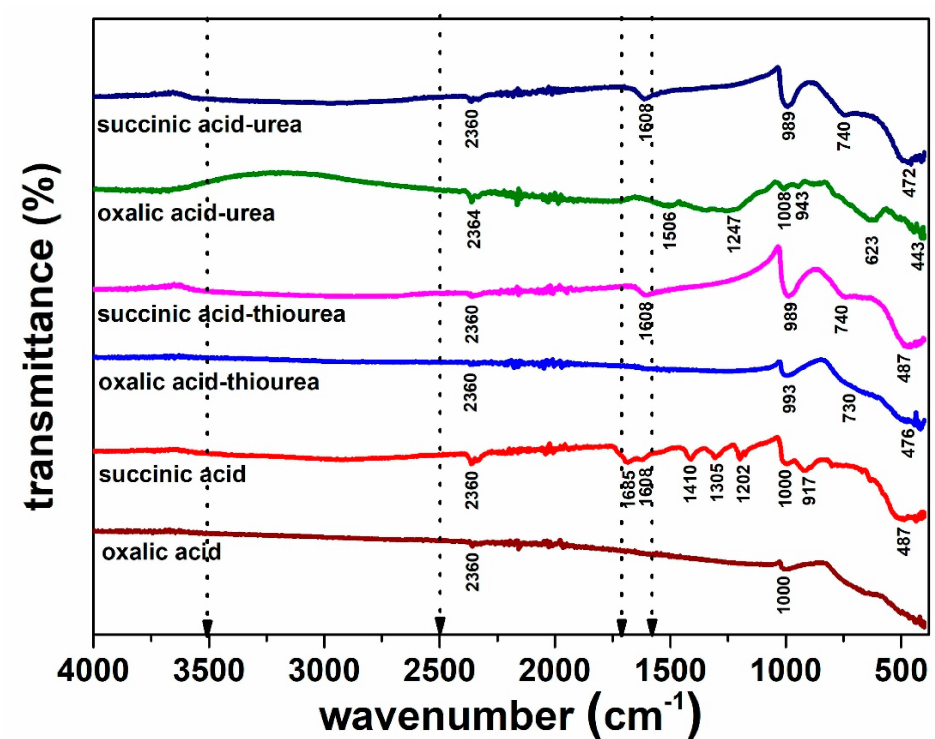
Figure 3. FTIR spectra of the final synthesized materials using oxalic acid without additives, succinic acid without additives, oxalic acid—thiourea, succinic acid—thiourea, oxalic acid—urea, and succinic acid—urea (from bottom to